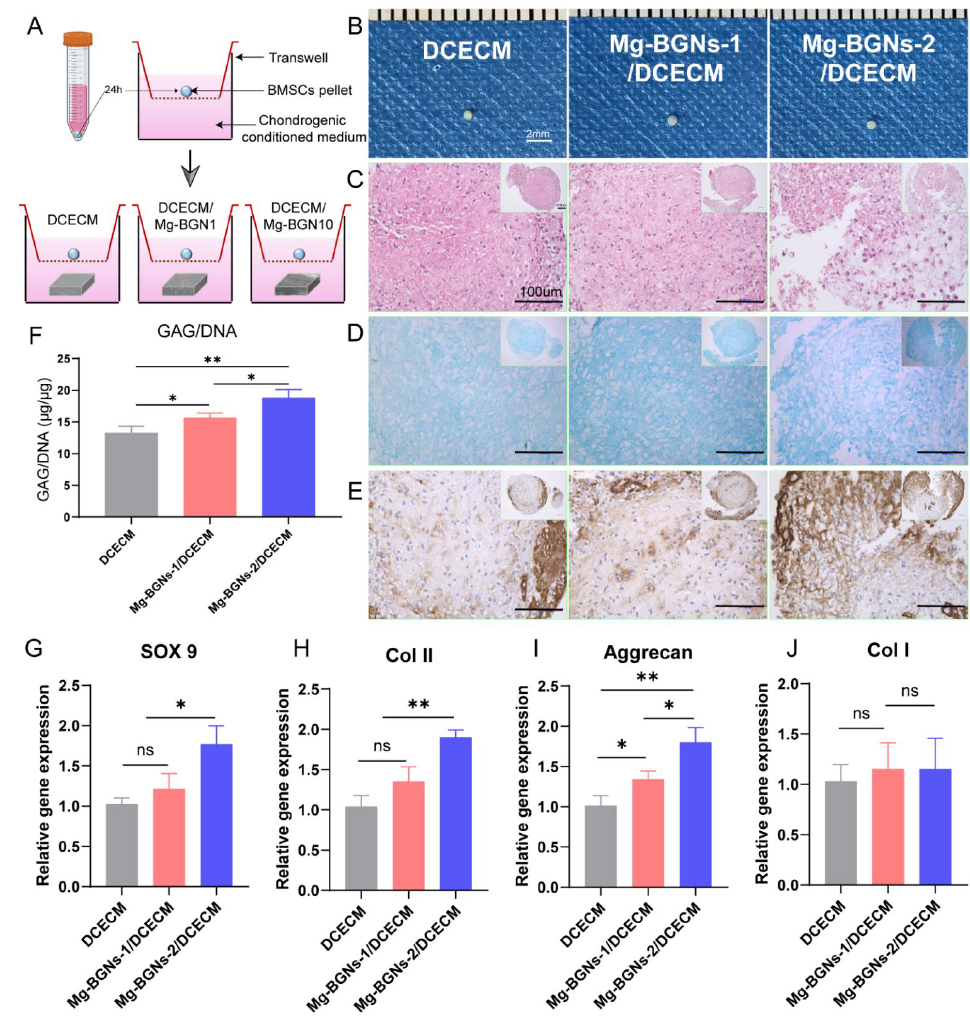
Figure 7. The chondrogenic effects of the DCECM, Mg-BGNs-1/DCECM and Mg-BGNs-2/DCECM scaffolds: ( A ) General scheme of the in vitro induction of chondrogenesis in BMSC pellets treated with DCECM, Mg-BGNs-1/DCECM and Mg-BGNs-2/DCECM scaffolds; ( B ) The gross observation of the pellets treated with DCECM, Mg-BGNs-1/DCECM and Mg-BGNs-2/DCECM scaffolds for 21 days; ( C ) HE staining of the pellets; ( D ) AB staining of the pellets; ( E ) collagen II staining of the pellets; ( F ) GAG normalized by DNA content of the pellets; data are expressed as mean ± standard deviation ( n = 3; * p < 0.05, ** p < 0.01). ( G – J ), RT-PCR of SOX 9 ( G ); Collagen II ( H ); aggrecan ( I ); and Collagen I ( J ) from BMSC pellets treated with DCECM, Mg-BGNs-1/DCECM and Mg-BGNs-2/DCECM scaffolds for 21 days. Data are expressed as mean ± standard deviation ( n = 3; * p < 0.05, ** p <